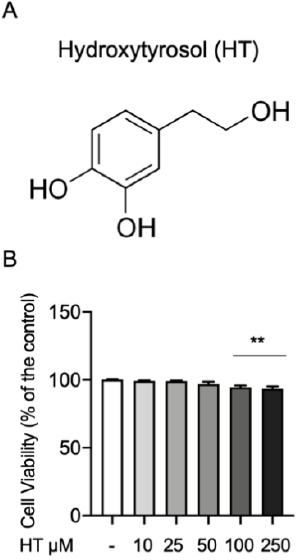
Figure 1. ( A ) Chemical structure of hydroxytyrosol and ( B ) effect on cell viability MTT assay. Data representative of at least three experiments, means ± SEM; * p < 0.05 vs. control; ** p < 0.01 vs. control.